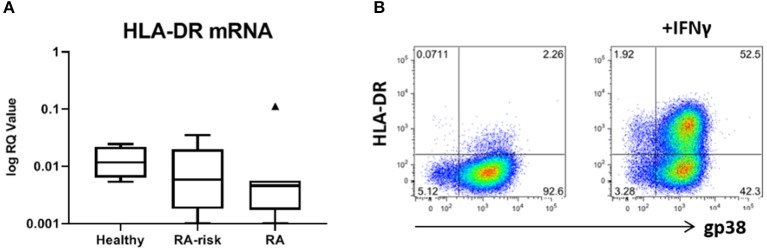
Expression of HLA-DR by human LNSCs. (A) mRNA expression levels of HLA-DRA was assessed by qPCR and data is presented in Tukey boxplots (healthy n = 7, RA-risk n = 8, RA n = 7). (B) Flow cytometry gating strategy used to identify CD45-CD31- stromal cells according to their podoplanin (gp38) and HLA-DR (MHC class II) expression. Gating was based on negative isotype staining. Pictures display 1 representative donor out of 13 donors tested (healthy n = 5, RA-risk n = 5, and RA n = 3). Numbers adjacent to the outlined areas indicate percentage of cells in the gated population.